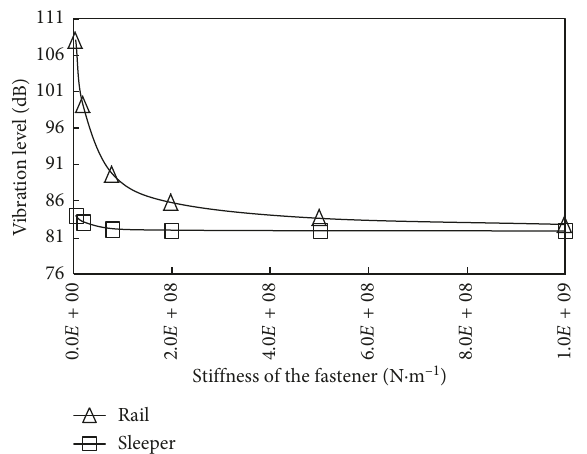
Figure 10: The influence of stiffness of the rubber pad on the vibration power